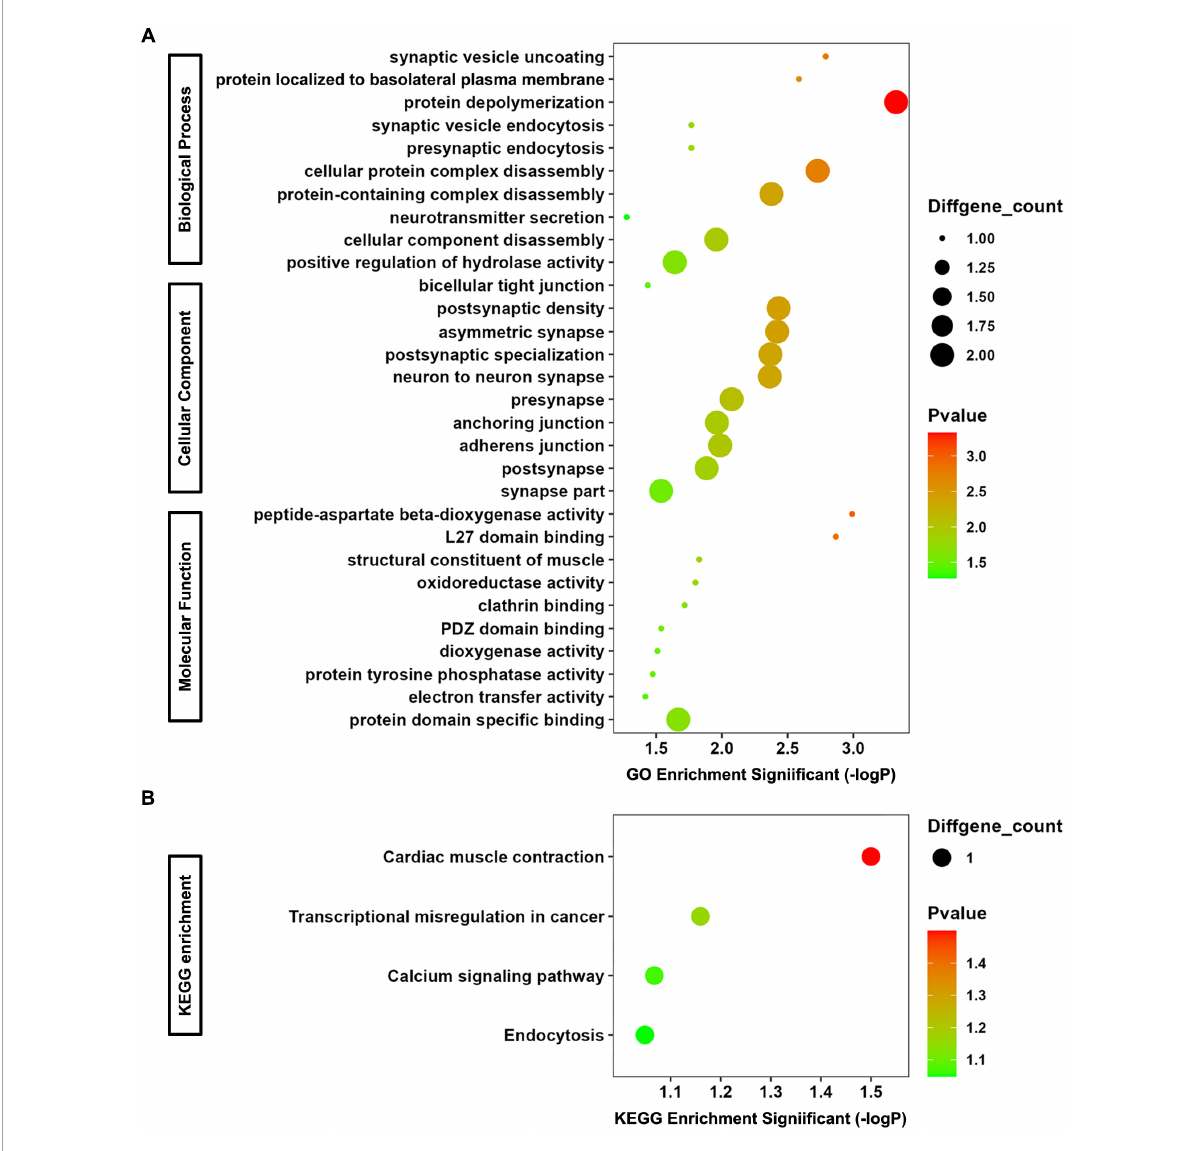
FIGURE2 GO and KEGG Enrichment Analyses for co-DEmRNAs and target genes of co-DEmiRNAs. (A) Bubble chart of GO analysis. (B) Bubble chart of KEGG analysis.